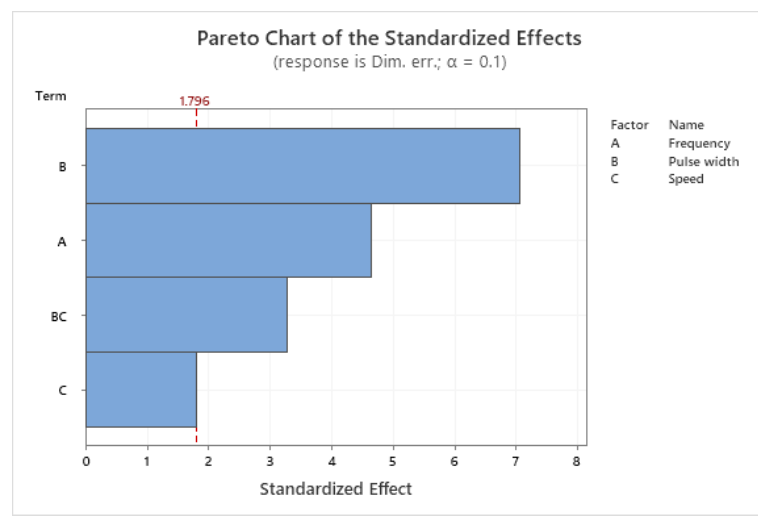
Figure 5 depicts the Pareto diagram for Dimensional error.